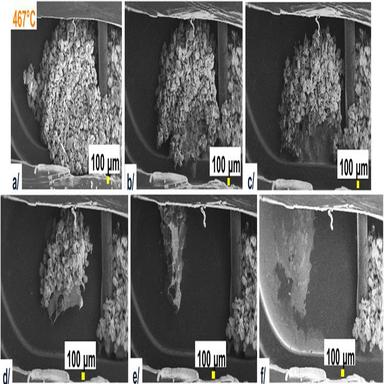
Thermally-induced transitions of ground LiBr under secondary vacuum during the heating step maintained at 467 °C.